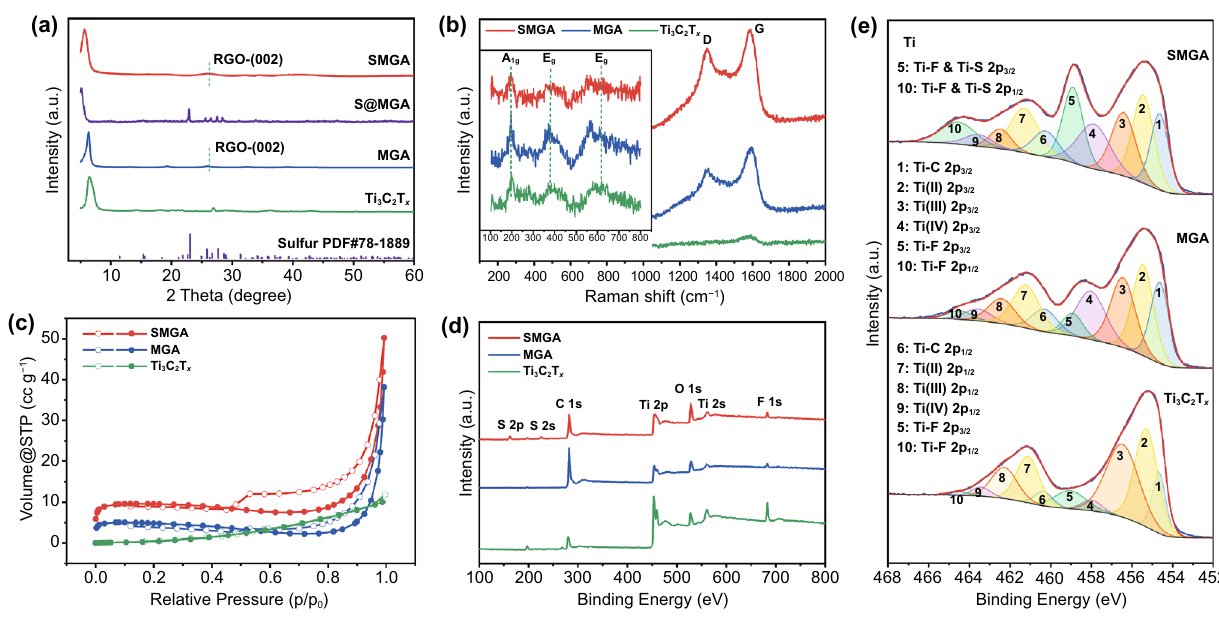
Fig. 4 a XRD patterns of the Ti 3 C 2 T x , MGA, MGA@S, and SMGA. b Raman spectra of Ti 3 C 2 T x , MGA, and SMGA. c N 2 adsorption–des- orption isotherms of